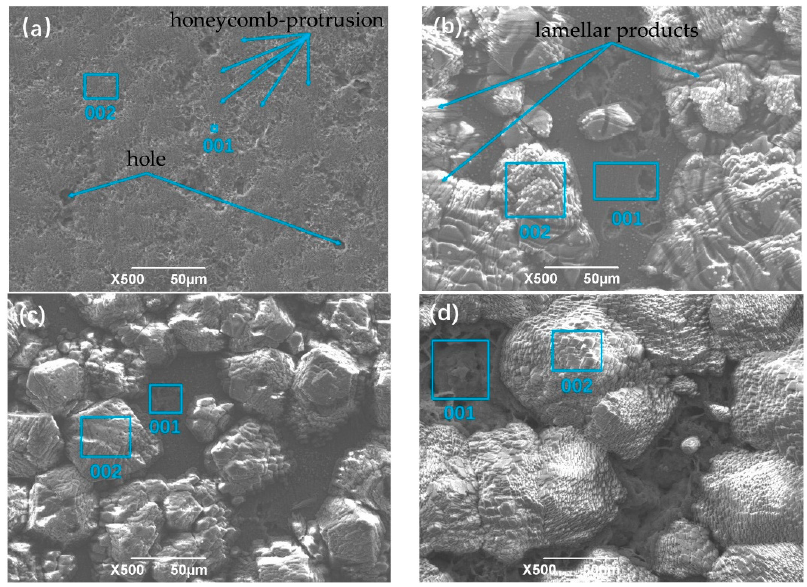
Figure 4. Microstructures of the corrosion products at 0 r/min ( a ), 60 r/min ( b ), 120 r/min ( c ), and 180 r/min ( d ), respectively.